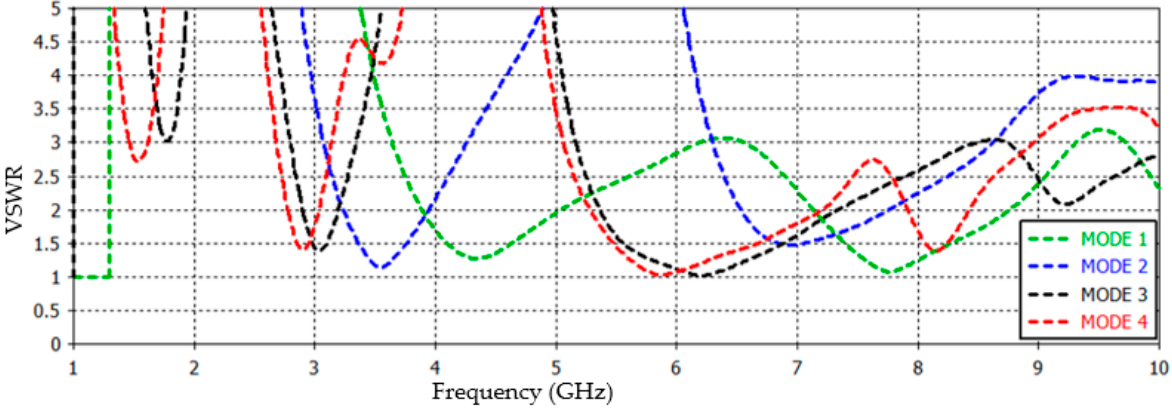
Figure 9. VSWR of the proposed antenna in different operating modes.